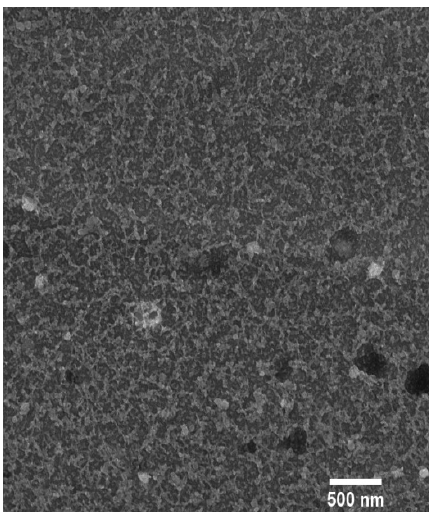
Figure 6. Distribution of precipitates in the sample CD30 and ageing at 120 °C for 12 h.